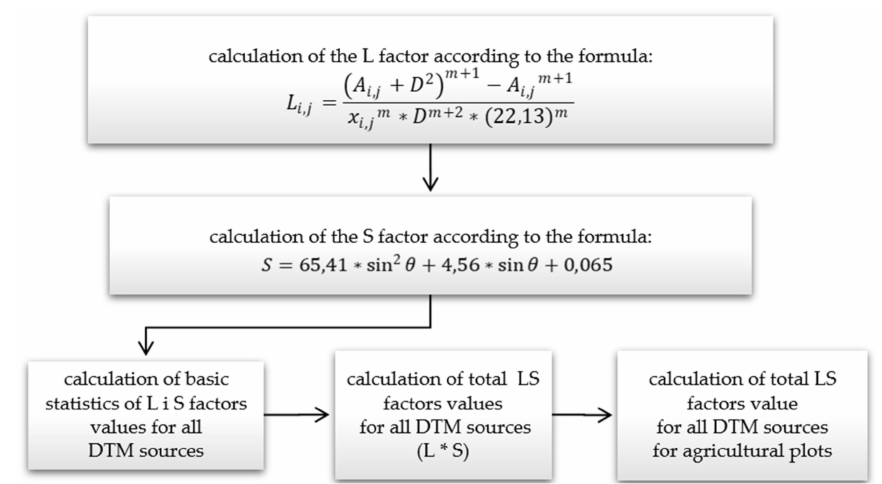
Figure 6. The methodology of calculating and comparing the values of the slope length (L) and steepness (S) factors (step 3).